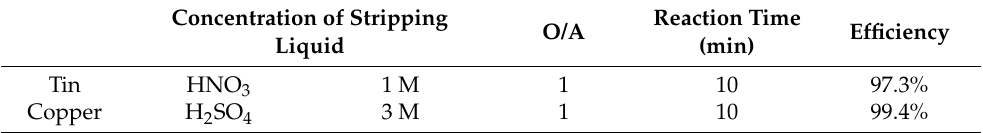
Table 5. Optimal parameters of stripping